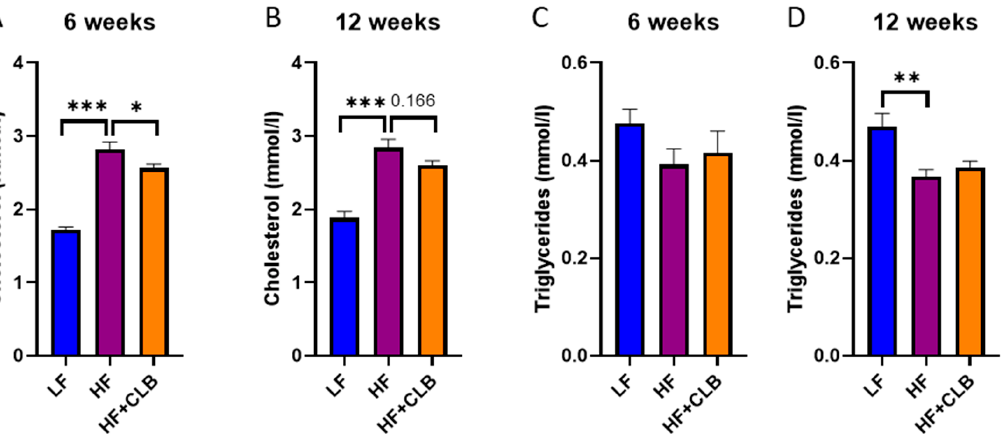
Figure 5. Cholesterol and triglycerides. Mice were divided into six groups to receive either a low-fat diet (10% of energy from fat, LF), high-fat diet (46% of energy from fat, HF), or cloudberry-supplemented high-fat diet (HF+CLB) for six ( A , C ) or twelve ( B , D ) weeks. The serum cholesterol levels ( A , B ) and the serum triglyceride levels ( C , D ) are expressed as mmol/L. The data were analyzed with one-way ANOVA and Bonferroni post-test, * p < 0.05, ** p < 0.01, and *** p < 0.001. The values represent mean + SEM, n = 12 mice per group.